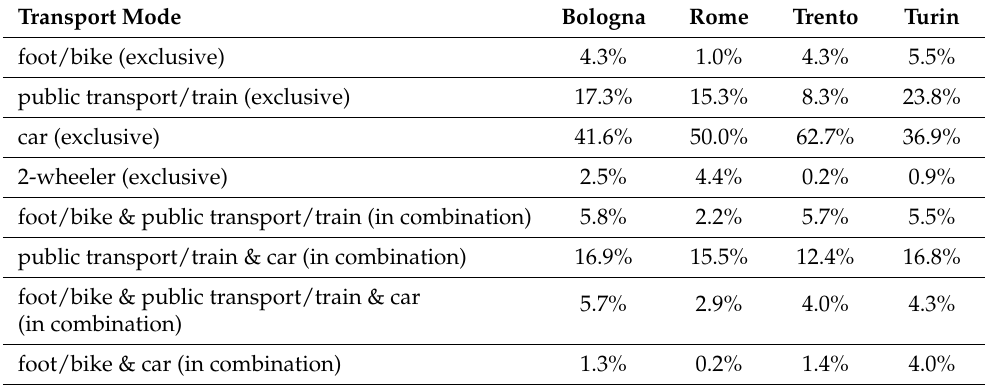
Table 2. Transport modes in the four cities.